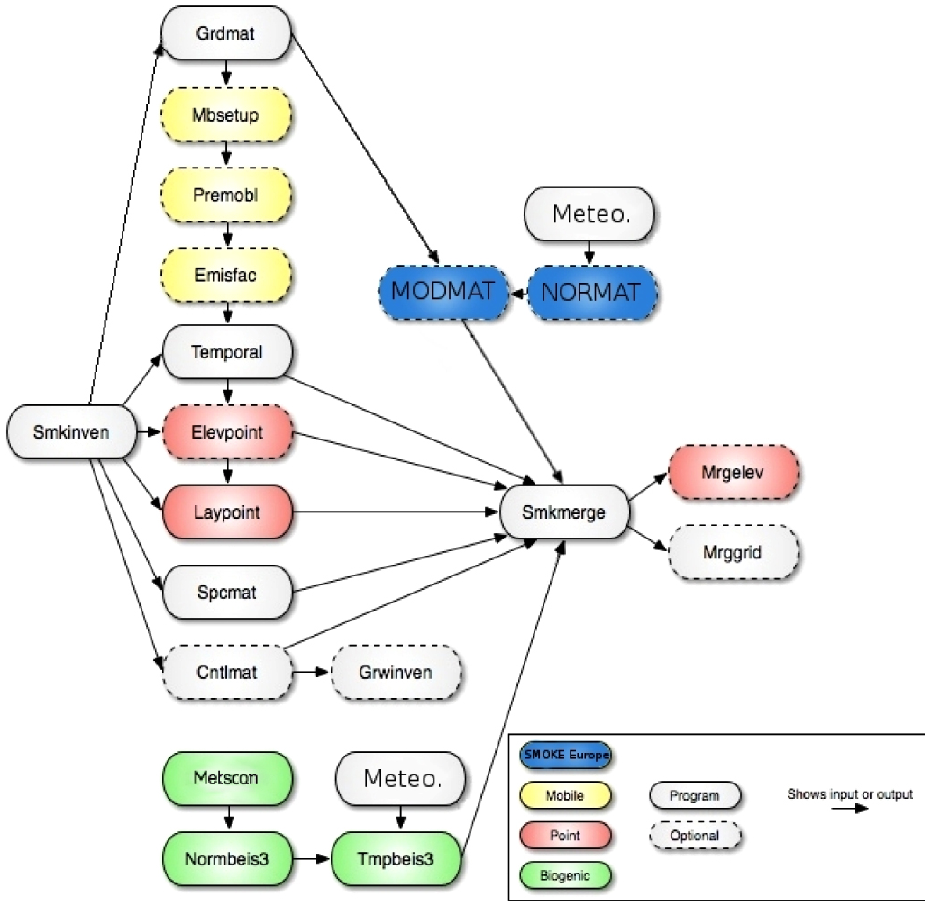
Fig. 1. SMOKE and BEIS3 (green) core programmes including modifications for SMOKE EUROPE (blue). Short descriptions of the most important modules can be found in Appendix A (Baek et al.,